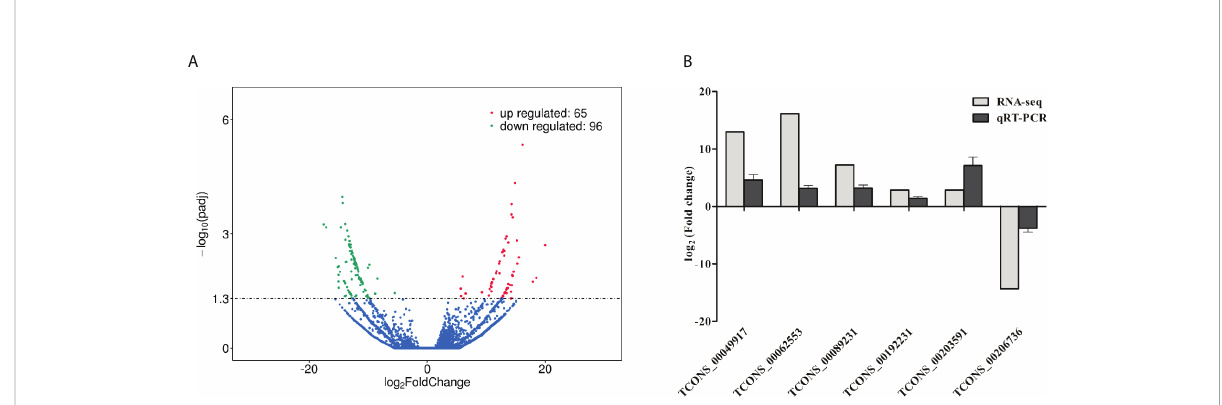
FIGURE 2 Analysis and validation of DE lncRNAs in ETEC-infected IPEC-J2 cells versus wild-type cells. (A) Volcano plot of DE lncRNAs. The x-axis indicates the average values of log 2 (Fold change), and the y-axis indicates the average values of log 10 (padj). Comparing the expression levels of ETEC-infected cells versus wild-type cells, the red dots represent the signi fi cantly up-regulated lncRNAs (P<0.05), and the green dots display signi fi cantly down-regulated lncRNAs (P<0.05), and the blue dots indicate the lncRNAs with no statistically difference (P>0.05). (B) Validation of DE lncRNAs using qRT-PCR. The y-axis displays the relative DE lncRNA expression which is represented with log 2 (Fold change) comparing infected versus wild-type cells. The qRT-PCR analysis was performed using the 2 - DD Ct method normalized to